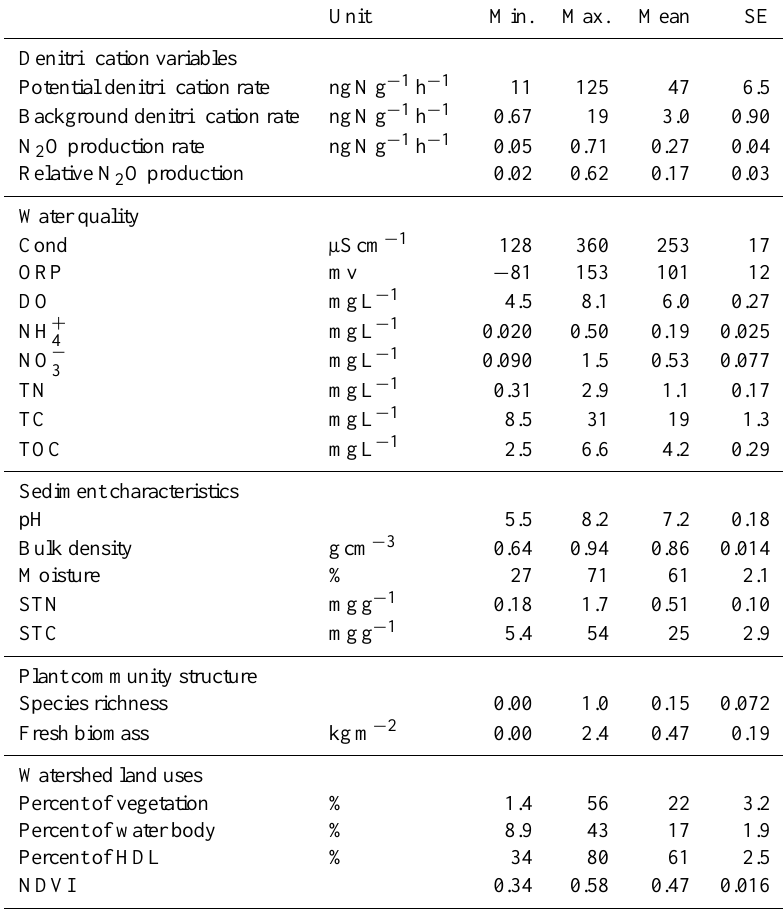
Table 1. Summary statistics for sediment denitrification variables, within-lake characteristics and watershed land uses ( N = 20). Unit